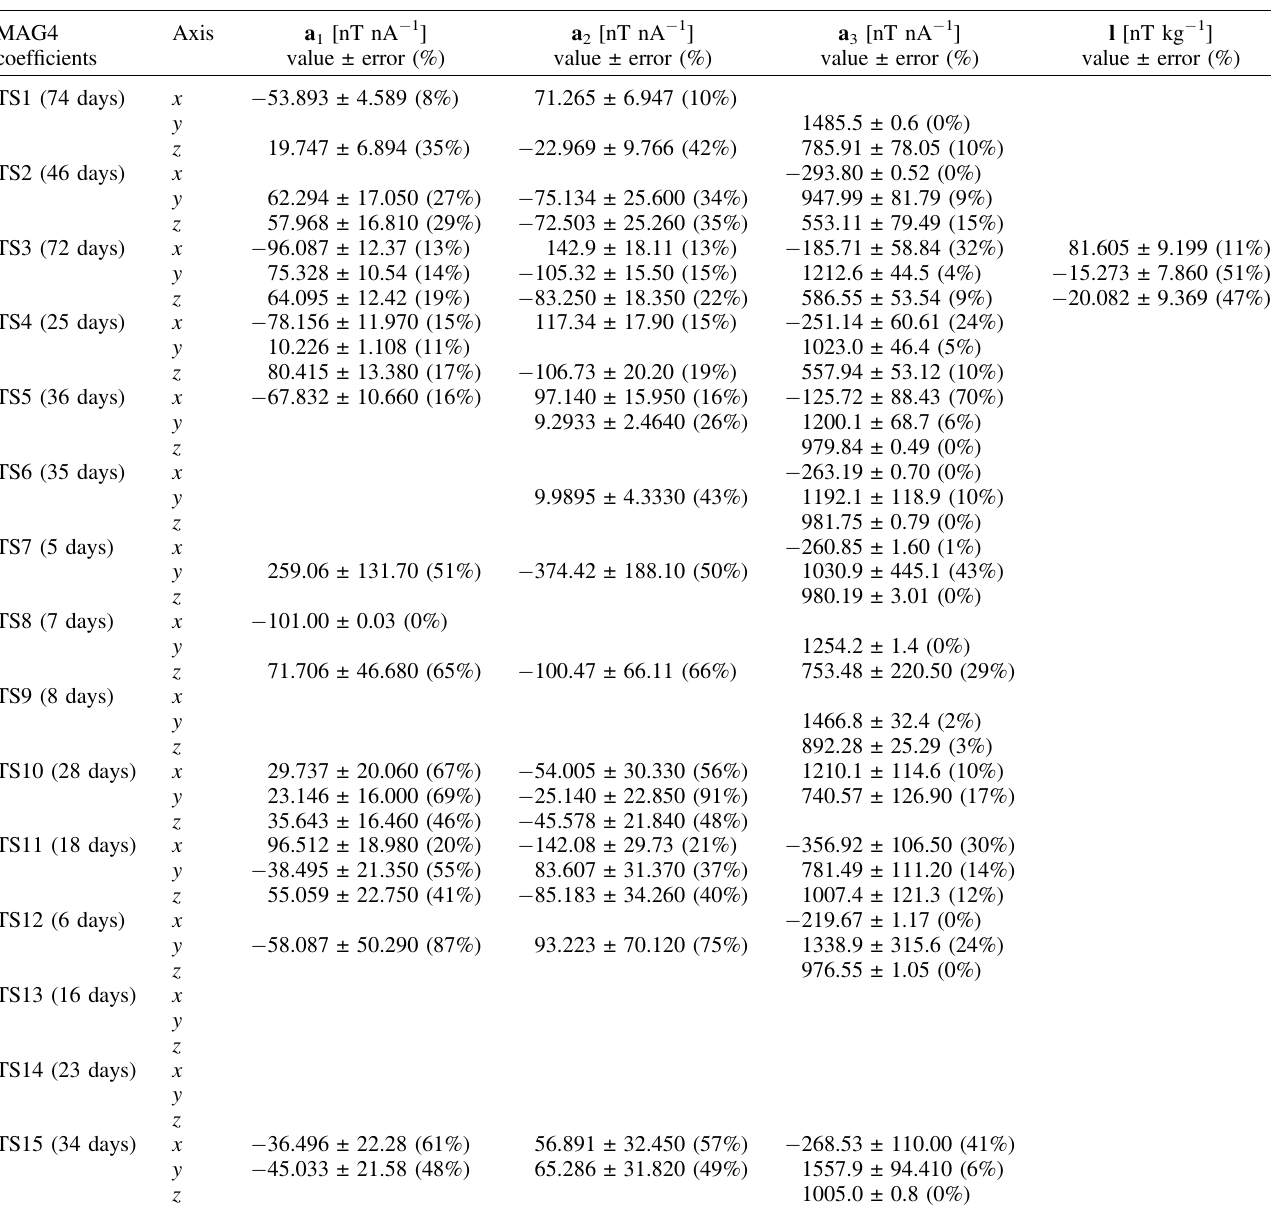
Table 6. Same as Table 3 for the PY magnetometer. MAG4 coef fi